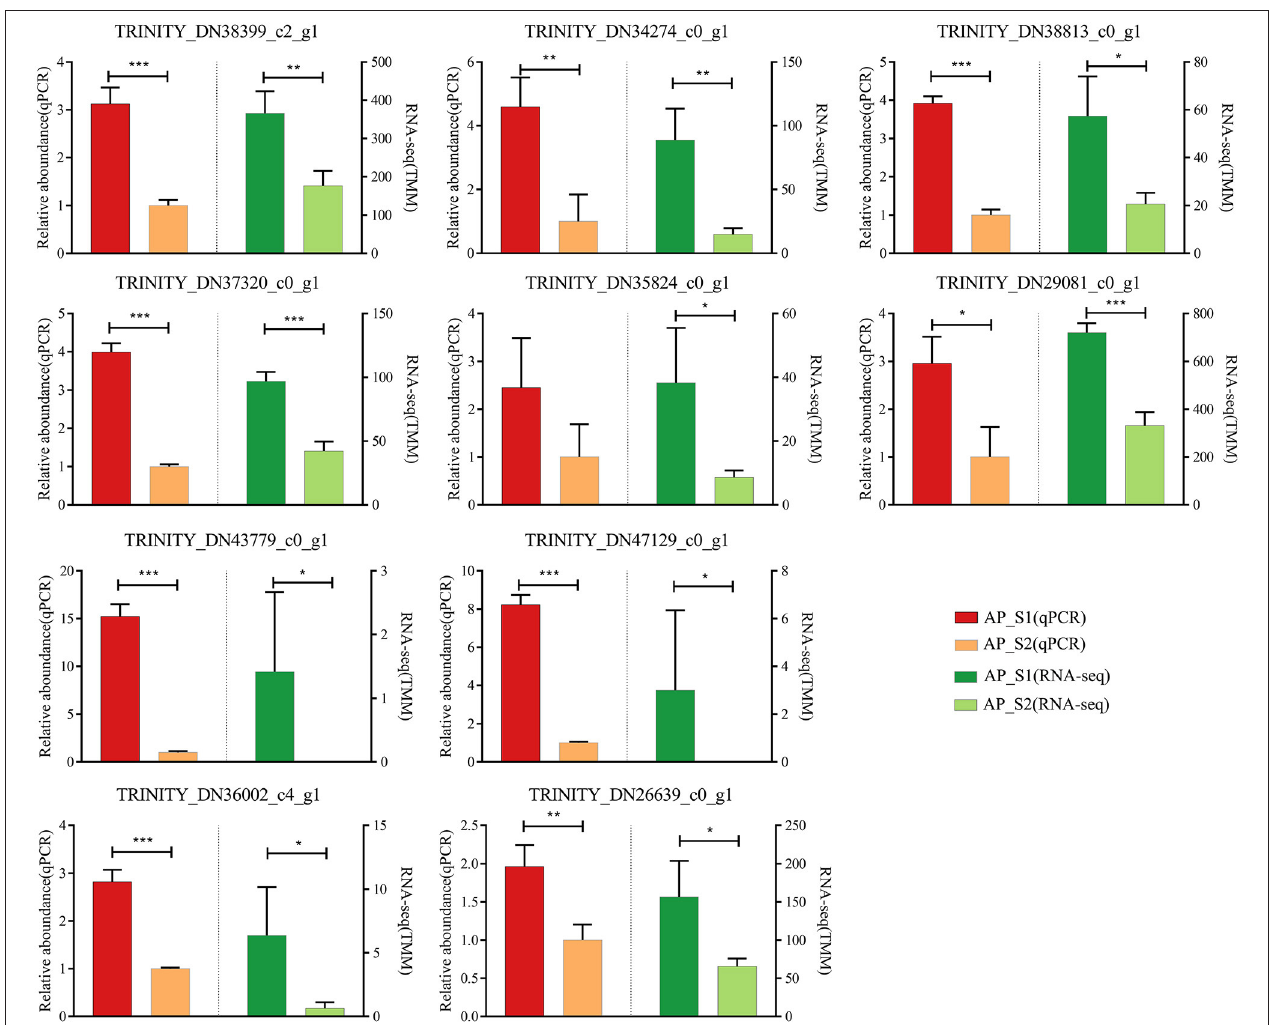
FIGURE 7 | Verification of the 10 selected DEGs in RNA sequencing (RNA-Seq) by the quantitative reverse transcriptase-PCR (qRT-PCR). Left half of bar plot shows the expression levels determined by the qRT-PCR, whereas the right half indicates the results from the RNA-seq. * P < 0.05, ** P < 0.01, *** P <